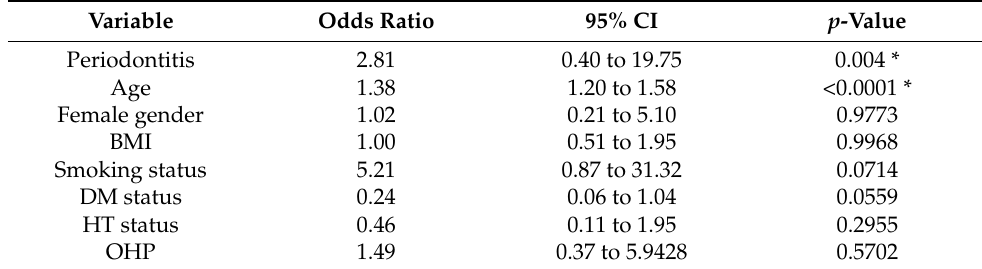
Table 5. Multinomial logistic regression